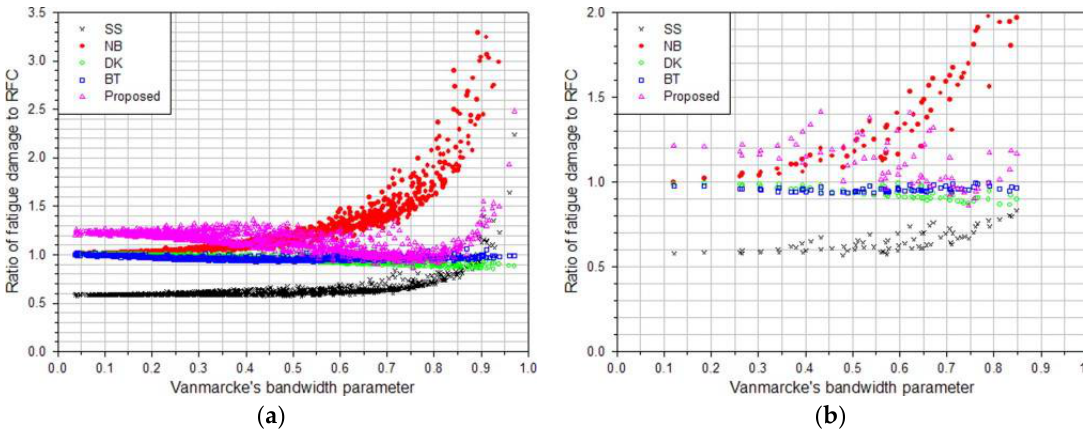
Figure 8. Example of comparison in [37] with the same power spectra used ( a ) in [16] and ( b ) in [15] (SS = simple sum of damage of frequency components in trimodal spectrum, NB = narrow band formula in Equation (5), DK = Dirlik, BT = TB method, Proposed = method proposed in [37]). Reproduced from [37] with permission from Elsevier.